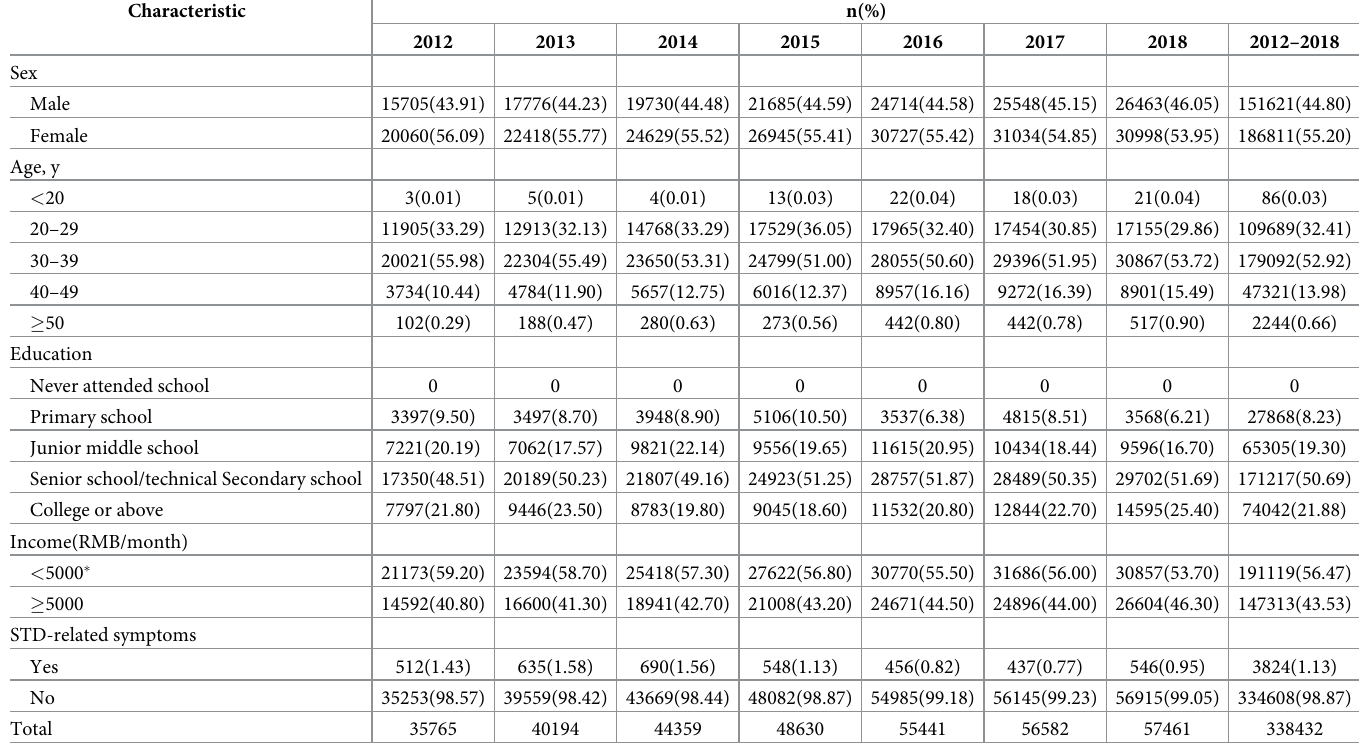
Table 1. Characteristics of infertile population in China from 2012-2018.